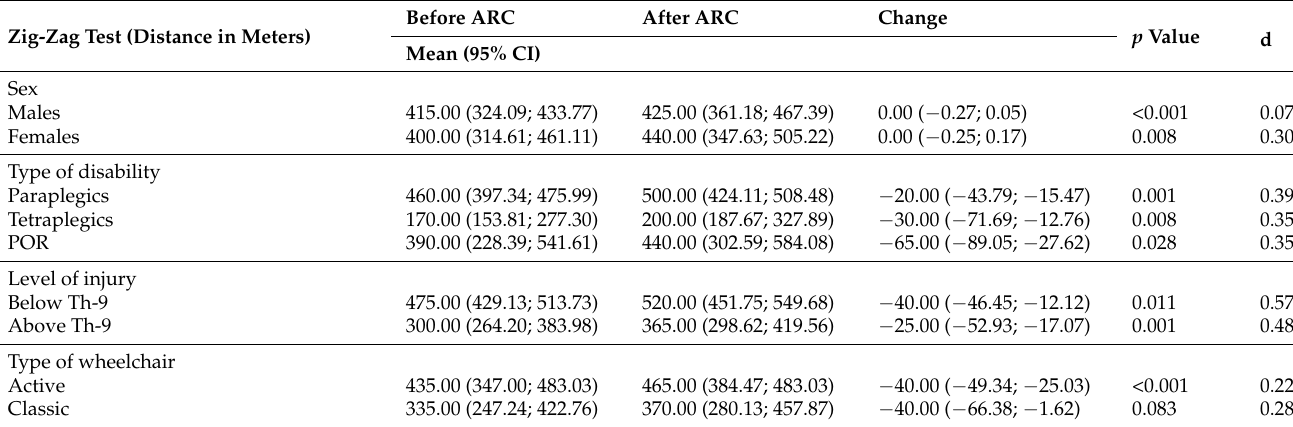
Table 5. The results obtained in the zig-zag test by the study participants before and after